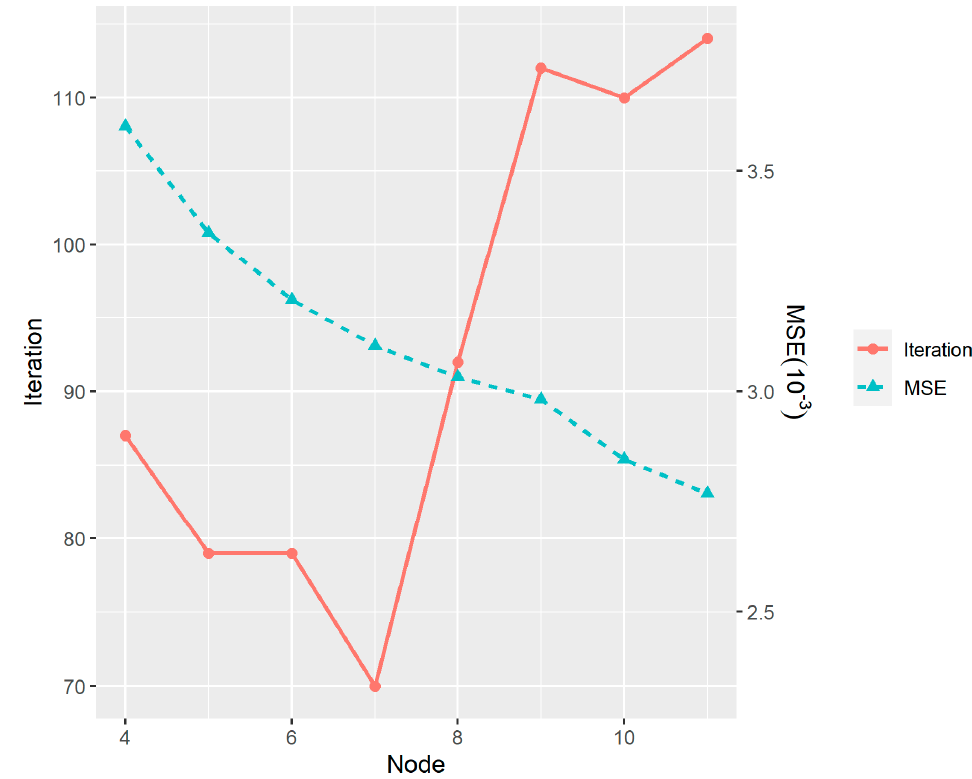
Figure 6. The number of iterations and MSE of BP model in the hidden layer.